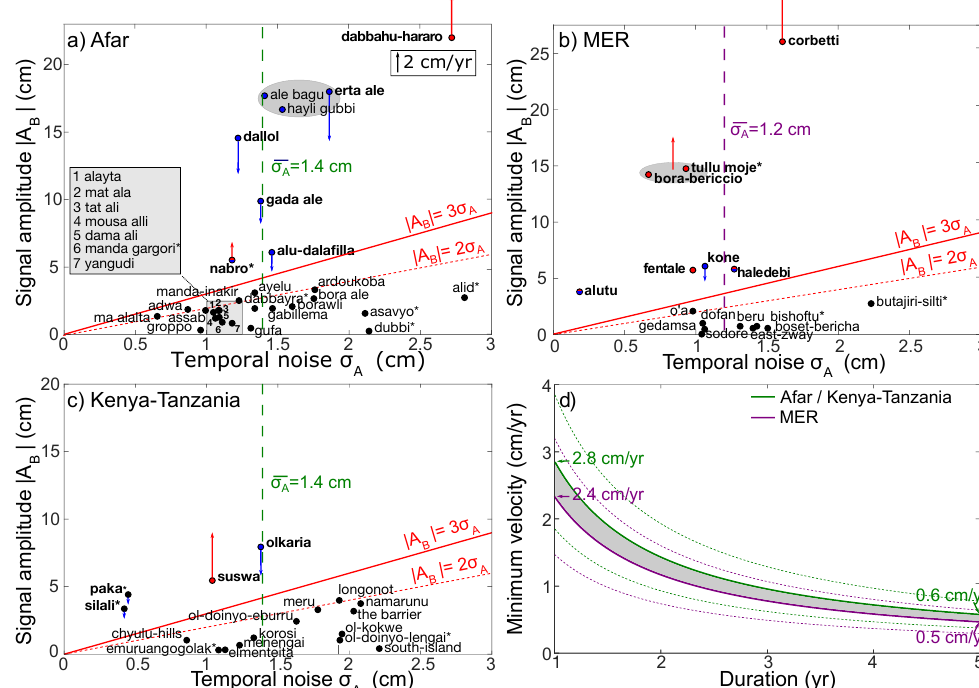
Figure 5. Limit of detection of displacements for the different sections of the rift: ( a ) Afar, ( b ) MER and ( c ) Kenya-Tanzania. The signal amplitude corresponds to the absolute value of the cumulative displacement recorded by the time series after 5-years at the location (B). Temporal noise corresponds to the standard deviation of the 5-years time series at the location (A) outside the deformation. The red lines show the two detection thresholds: | A B | = 2 σ A and | A B | = 3 σ A . Volcanic centres with amplitude above 3 σ A are automatically classified as deformed volcanoes whereas volcanoes with amplitude between 2 σ A and 3 σ A need manual inspection. Arrows indicate the mean LOS velocity for the year 2019. Gray ellipse indicates cases for which one ground signal is identified on different neighboured volcanic centres. The symbol (*) indicates volcanic centres where phase- elevation corrections have been applied. Vertical dashed lines indicate the average temporal noise for each section of the rift, ( d ) minimum LOS velocity that will be detected as a function of the duration of the time series, assuming the threshold of 2 σ A . Solid lines are derived from the mean value of the temporal noise found in ( a – c ) and dashed lines indicate the confidence intervals within 1 standard